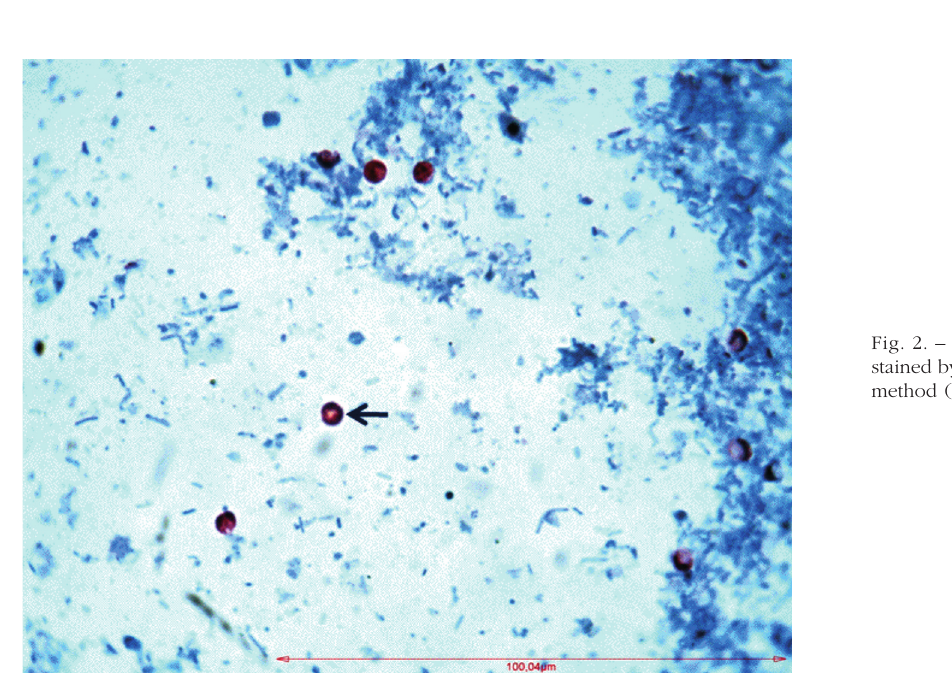
Table I. – The prevalence of Cryptosporidium infection, oocysts shedding and faecal consistency, in different age groups of naturally infected camels in Miandoab suburb, Iran (n = 170).